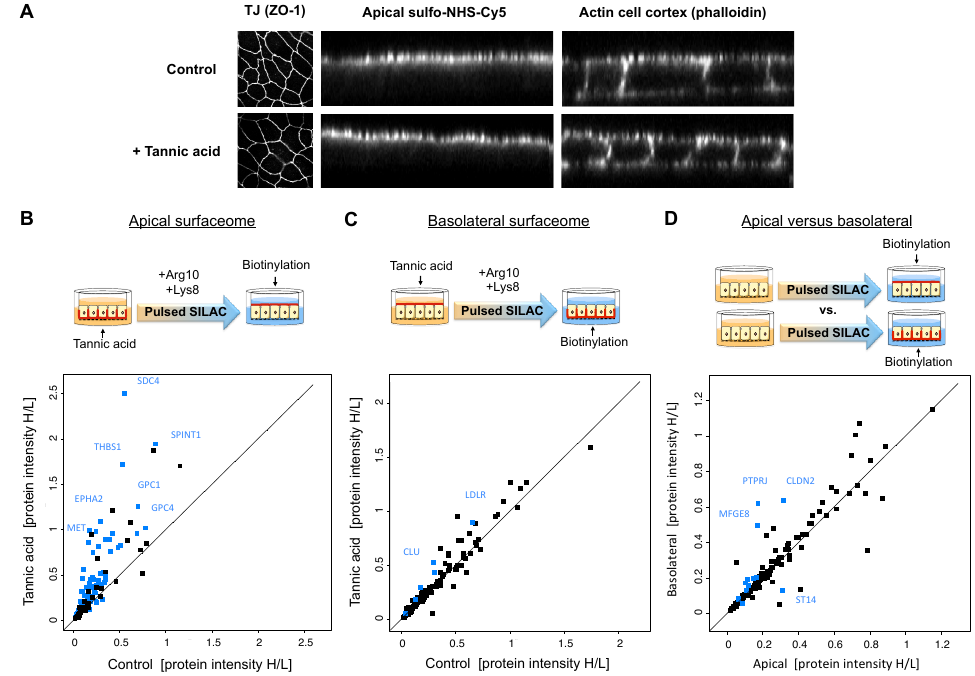
Figure 4. A pulsed SILAC experiment reveals flexibility in the delivery of newly synthesized proteins to the apical and basolateral surfaces upon side-specific blocking by membrane fixation using tannic acid. ( A ) Confocal microscopy imaging of filter-grown MDCK cells shows intact cell layer integrity 4 h after tannic acid treatment (0.5% for 10 min) compared with the untreated control, with no effect on the expression of the tight junction (TJ) protein ZO-1 (left panel) nor on the side-specific cell surface labeling with an NHS-conjugate (center panel). Staining of the actin cell cortex by phalloidin was used as a reference for cellular localization (right panel). ( B ) Delivery of many newly synthesized (heavy) proteins was increased to the apical surface upon basolateral tannic acid treatment. ( C ) Almost no changes in protein delivery to the basolateral surface proteins were observed upon apical tannic acid treatment. ( D ) Comparison of the heavy-to-light ratio of apical and basolateral surface proteins indicates that some newly synthesized proteins integrate more rapidly into either the apical or basolateral membrane domain, suggesting side-specific turnover rates for these proteins. Blue dots mark proteins that show statistically significant differences between conditions (shown are median values, n = 3, two-sided t -test FDR = 0.05, s0 =